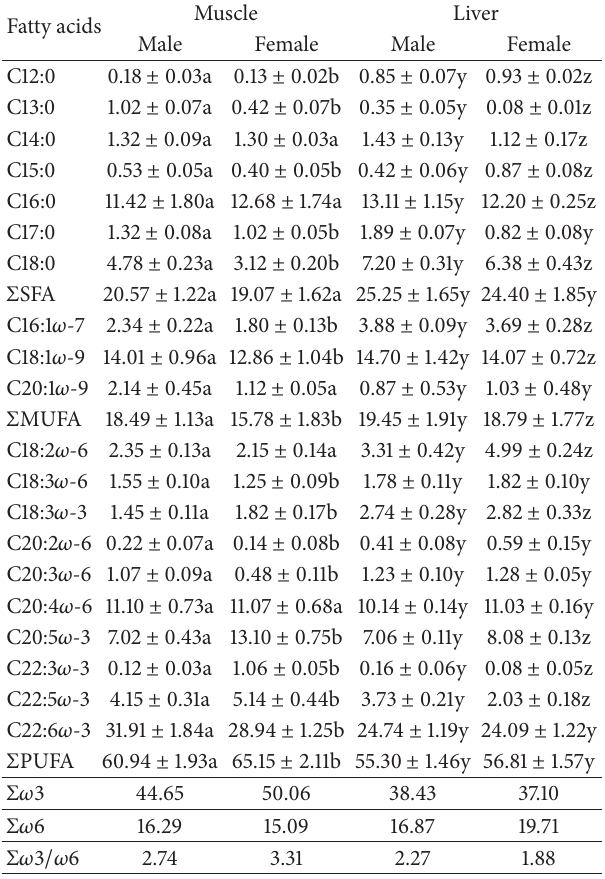
Table 3: Comparison of males and females in terms of muscle and liver fatty acid composition of phospholipid in L. lepidus